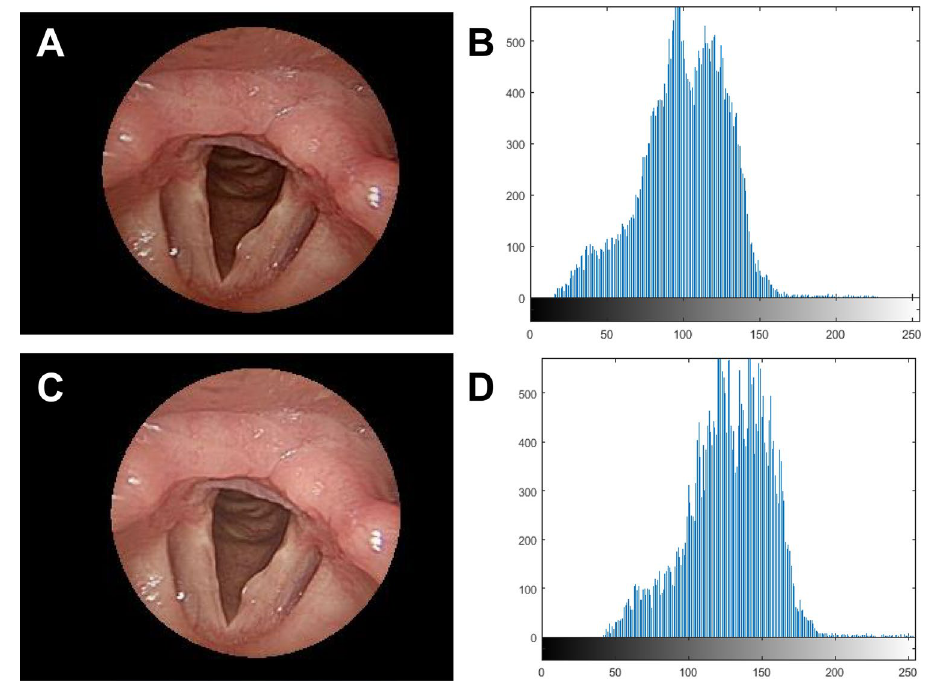
Figure 3. Image compensation. ( A ) Original image. ( B ) Original image brightness histogram (average value: 100.64). ( C ) Image compensation. ( D ) Image compensation brightness histogram (average value: